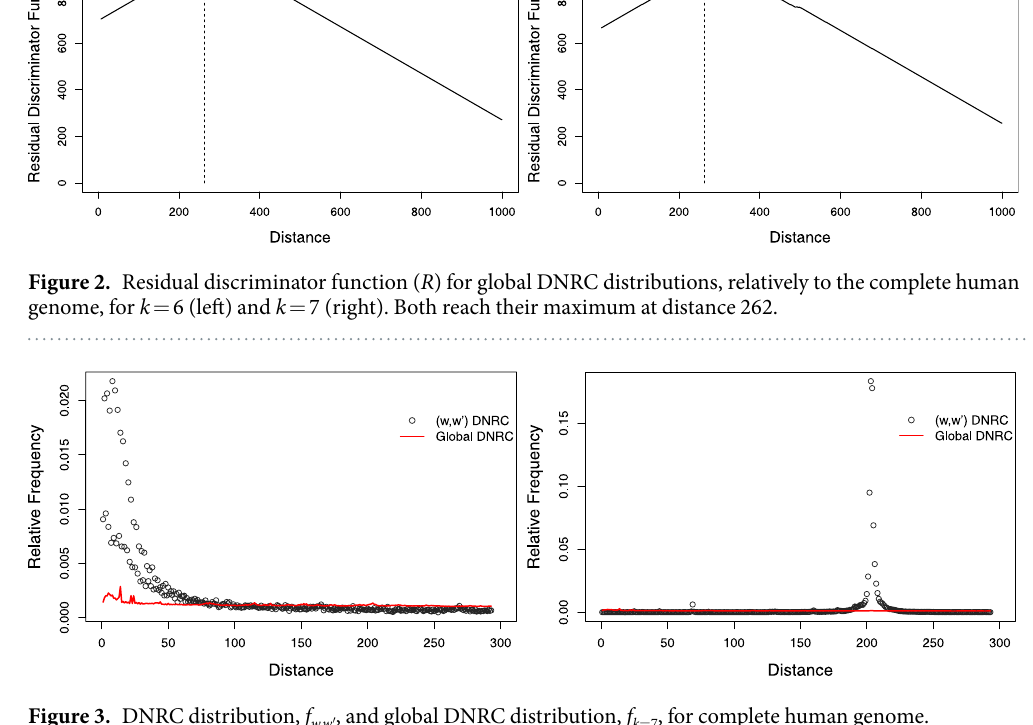
Figure 3. DNRC distribution, f w , w ′ , and global DNRC distribution, f k = 7 , for complete human genome. Overrepresentation of short distances in different ranges: w = ATATATG (left), w = GGCTCAC